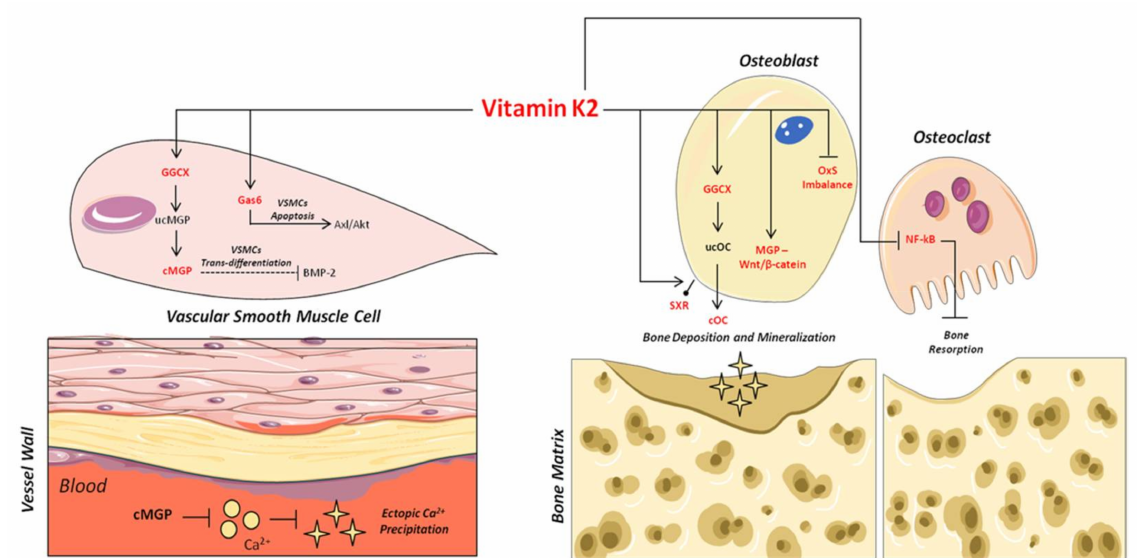
Figure 2. Mechanisms of action of VitK2 in “bone and vascular cross-talk”. At vascular level, VitK2, acting as cofactor for the enzyme GGCX, triggers the conversion of undercarboxylated MGP (ucMGP) in active carboxylated MGP (cMGP). The active cMGP could directly inhibit ectopic Ca2+ precipitation, but also VSMCst trans-differentiation through BMP-2. VitK2 can also inhibit VSMCs apoptosis through the Gas6/ AxL/Akt anti-apoptotic pathway. In bone tissue, VitK2 could promote osteoblasts proliferation and activity through MGP and Wnt/ β -catenin pathway, control of oxidative stress (Ox-S) imbalance, via SXR receptor, and the well-established GGCX-dependent pathway. VitK2 may also exert a control of osteoclasts activities through the inhibition of